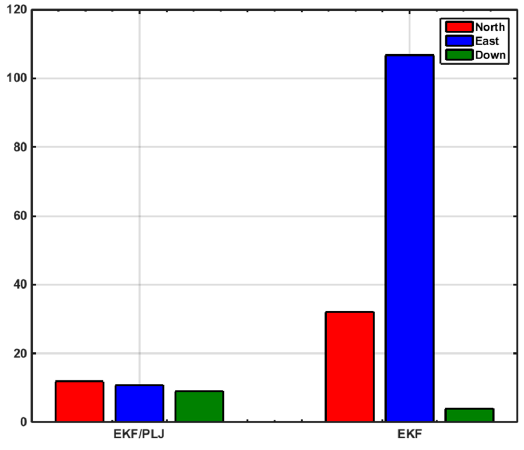
Figure 13. Maximum Position Error—Scenario #1.